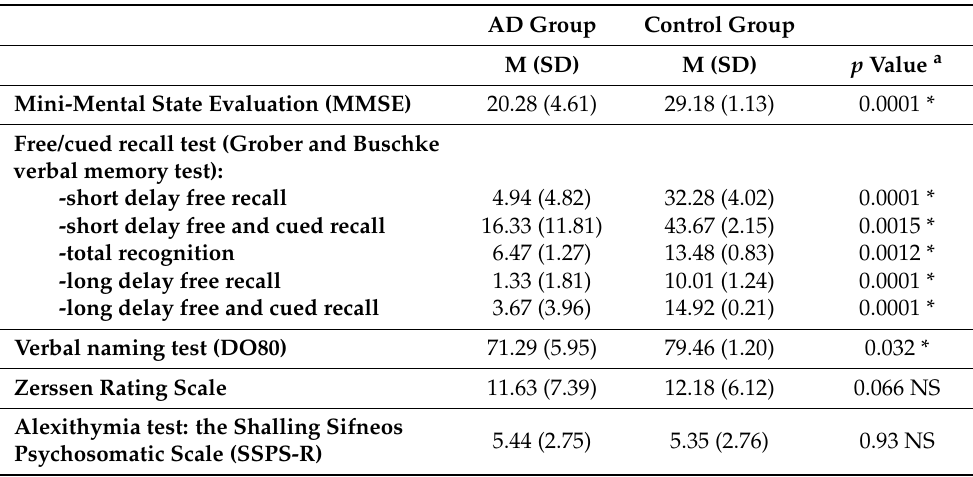
Table 2. Means (M) and standard deviations (SD) of neuropsychological tests in the AD and con- trol